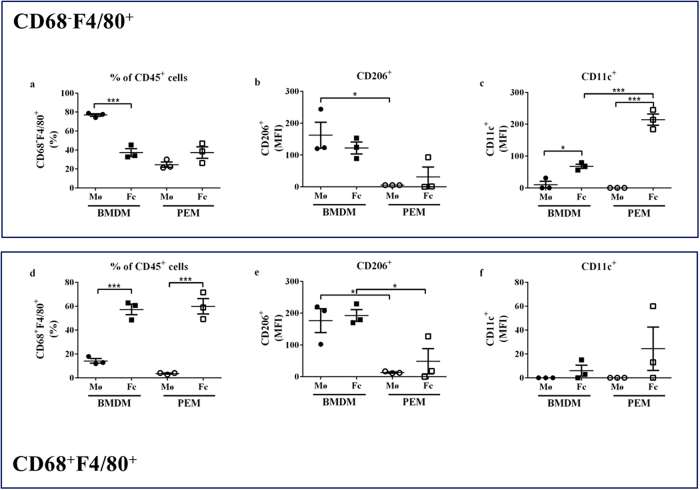
M1/M2 marker expression in BMDMs and PEMs.(a–f) Flow cytometry of BMDMs and PEMs after incubation with 0 μg/mL oxLDL (macrophage, Mø) or 25 μg/mL oxLDL (foam cells, Fc) for 24 hours (n = 3 mice for BMDMs and 3 pools of 4–5 mice for PEMs). For both single positive (CD68−F4/80+) and double positive (CD68+F4/80+) cells, the percentage of CD45+ cells (a,d), and MFI for CD206 (b,e) and CD11c (c,f) expression were detected. MFI: Mean Fluorescent Intensity. *p < 0.05, ***p < 0.001 as determined by 1-way ANOVA with Tukey’s post-test.